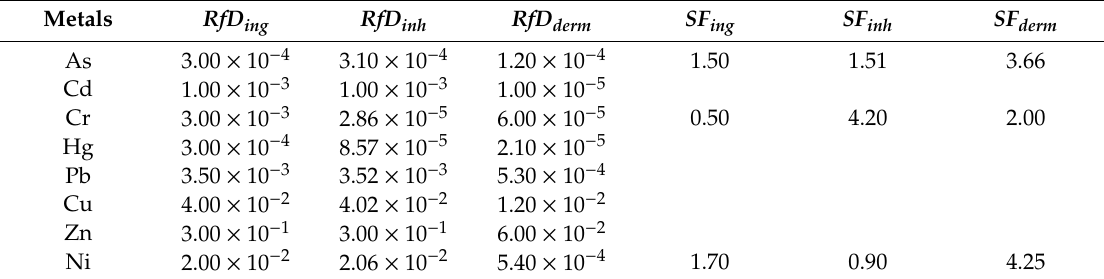
Table 2. The reference doses for noncarcinogenic metals (mg kg − 1 d − 1 ) and slope factors for carcinogenic metals (kg d mg − 1 )